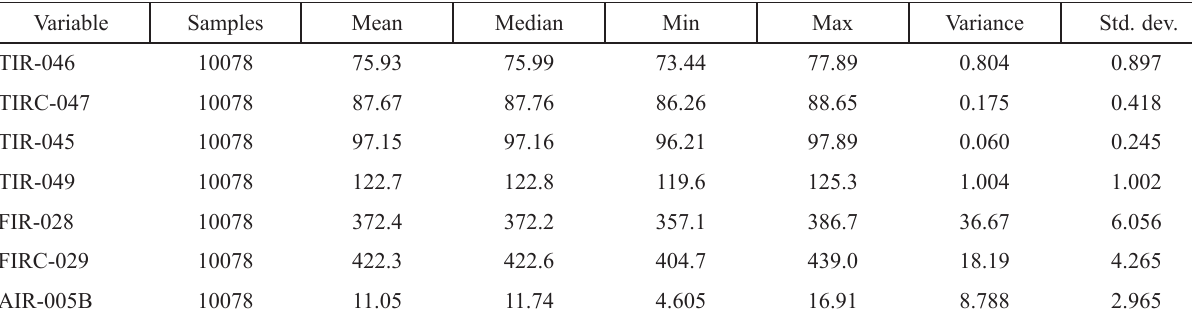
Table 9 – Descriptive statistics within 2016 data period 15